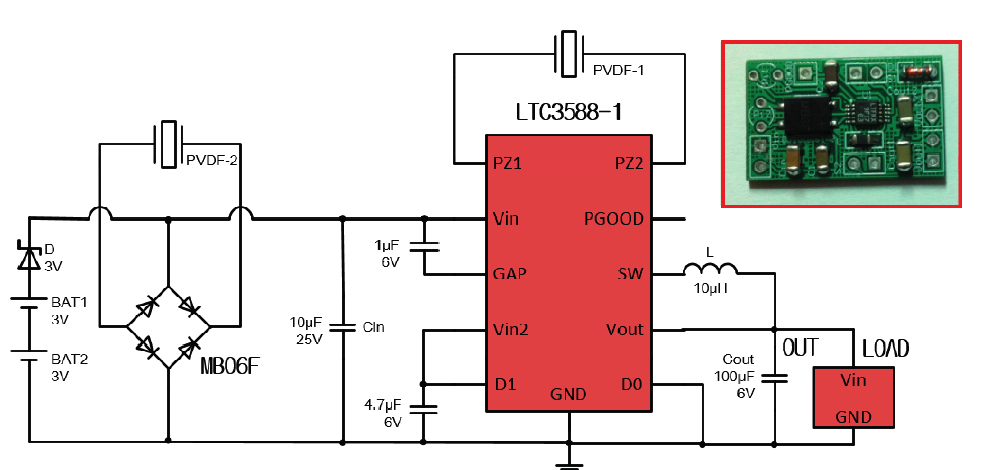
Figure 5. Schematic and physical photograph of the power management